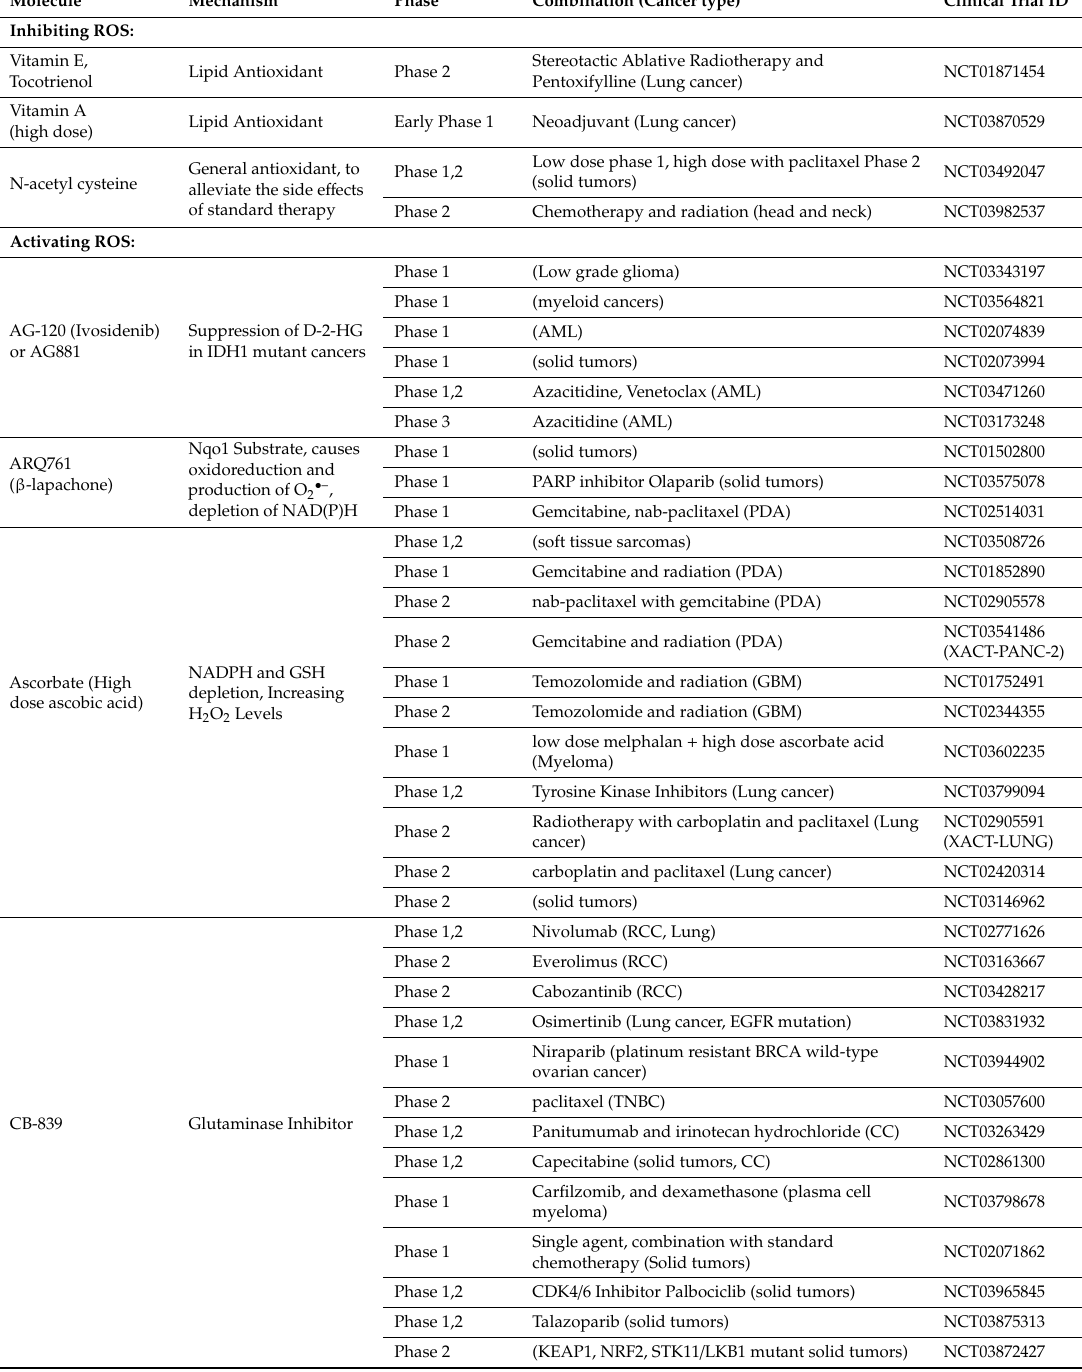
Table 1. Ongoing clinical trials with therapies directly or indirectly modulating ROS metabolism.